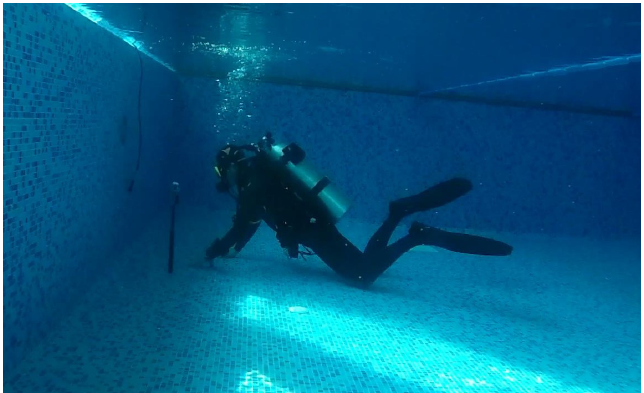
Figure 4. In experiment, one channel data acquisition system is used to record the diver’s breathing sound underwater. Sample rate is 50 kHz.